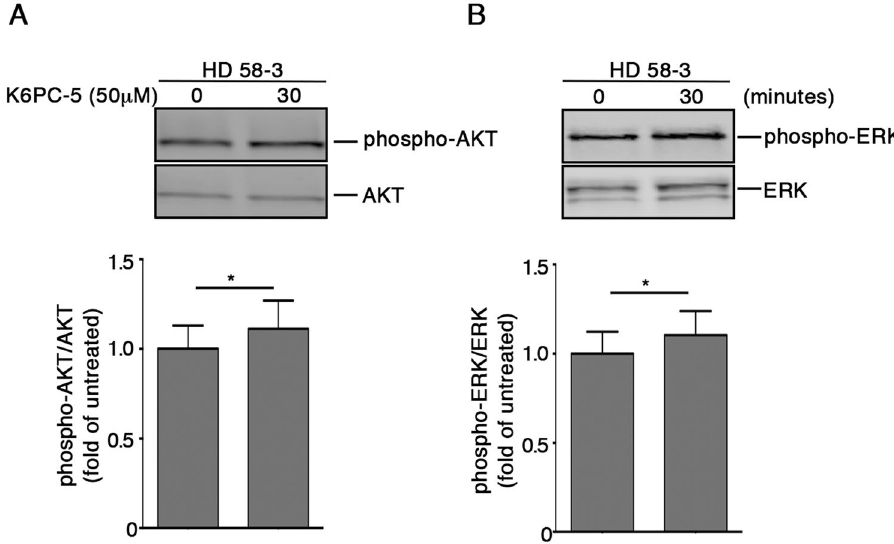
Figure 10. Pharmacological activation of SPHK1 evokes activation of pro-survival pathways in human iPSC- derived neurons. Representative cropped immunoblottings and densitometric analysis of AKT ( A ) and ERK ( B ) phosphorylation in iPSC-derived HD human neurons (day 65) after 30 minute of treatment with K6PC-5. Data are mean ± SD of three experiments, * p < 0.05 (Paired